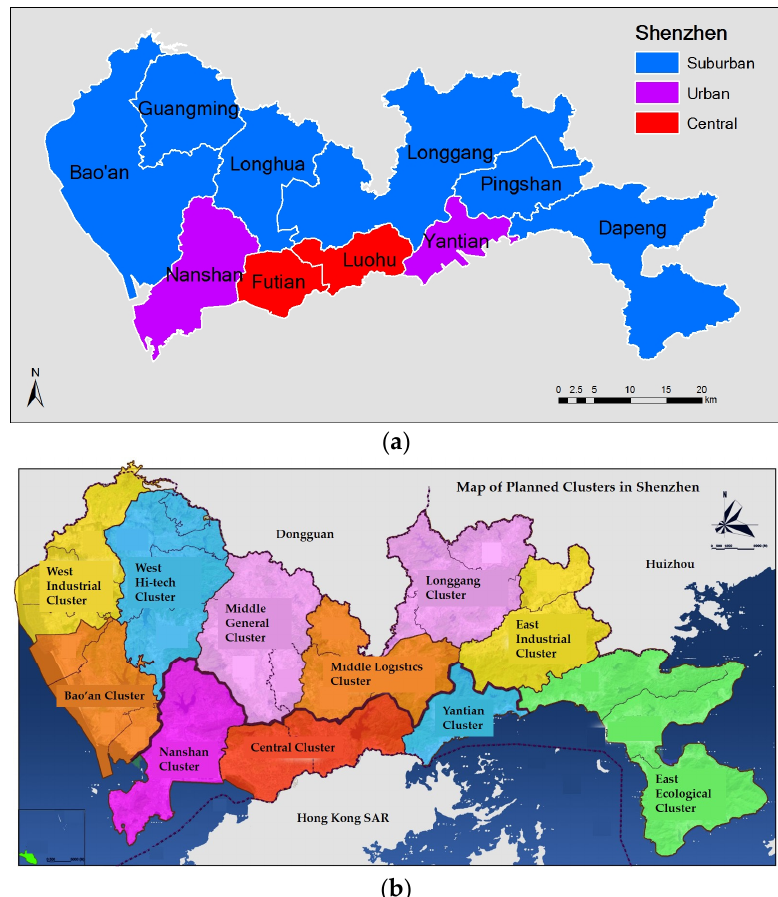
Figure 1. Map of Shenzhen in: ( a ) administrative districts; and ( b ) planned clusters.